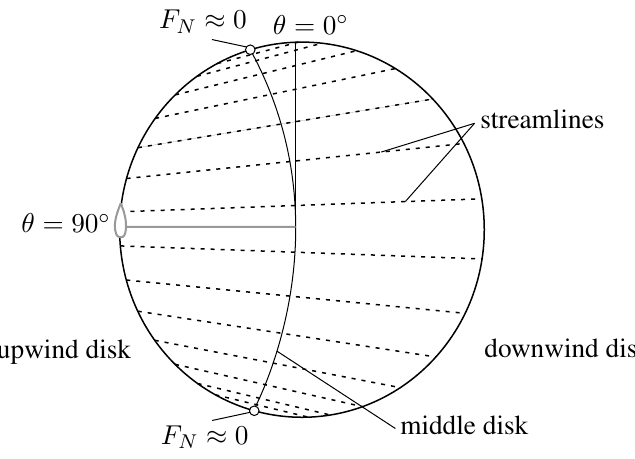
Figure 6. Definition of the blade azimuth angle θ from the normal